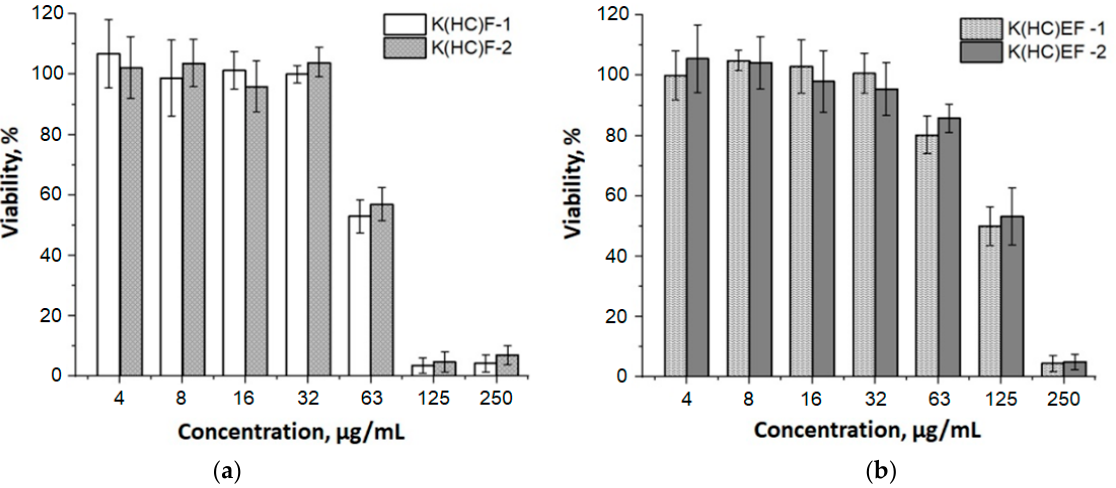
Figure 9. Viability of HEK 293 cells after incubation with samples K(HC)F-1 and K(HC)F-2 ( a ), and K(HC)EF-1 and K(HC)EF-2 ( b ) over 48 h. The data are shown as the mean ± SD ( n = 4).